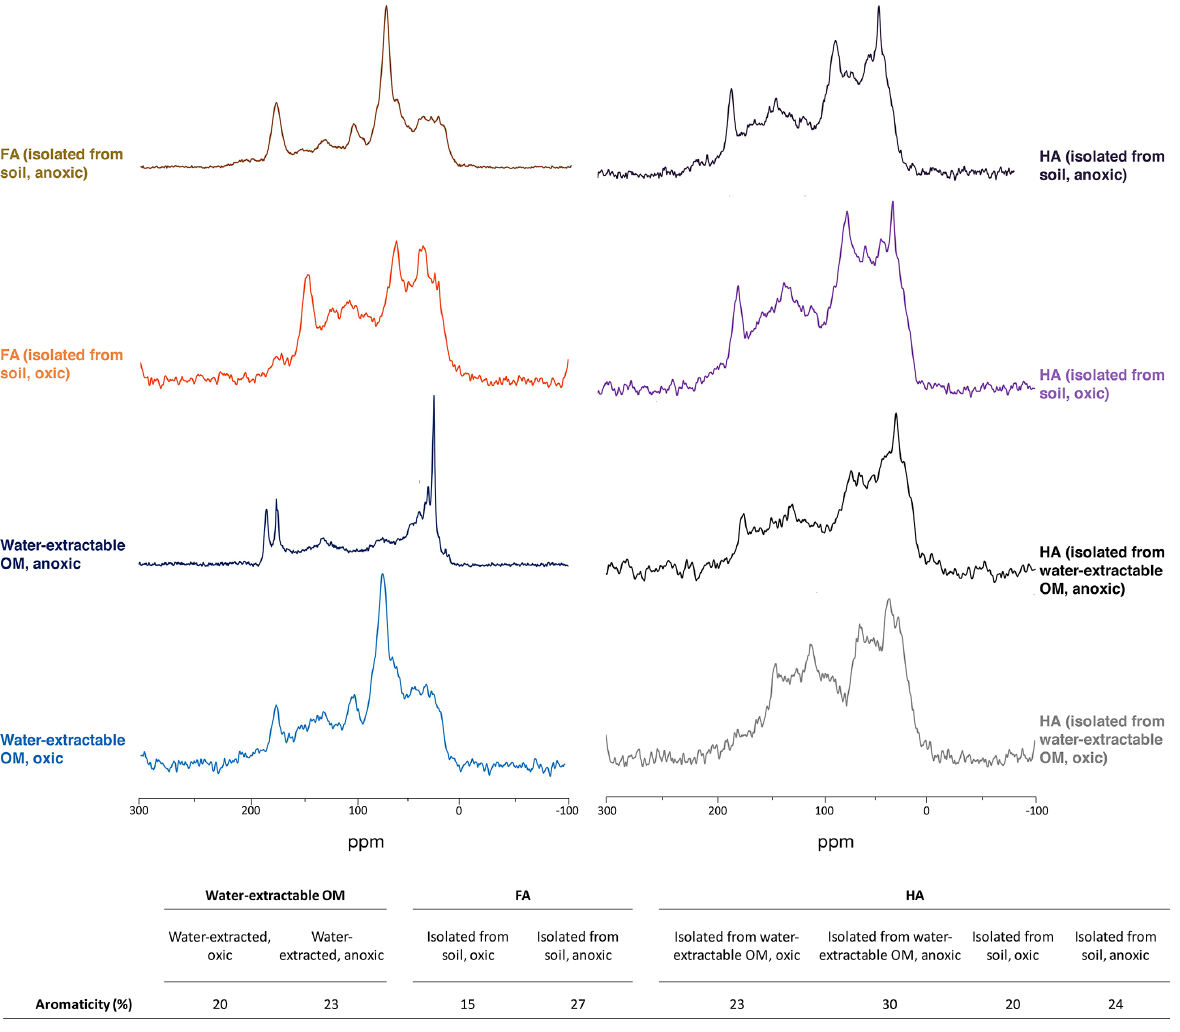
Figure 2. 13 C-NMR spectra of water-extractable OM, FA, and HA. All spectra were collected from freeze-dried extracts and the aromaticity of samples was calculated as the percentage of aromatic C peak area to the total peak area. The relative intensity distributions of specific chemical shifts are shown in the Supplement, Table S2. Spectra for FA isolated from water-extractable OM cannot be presented due to the lack of an adequate amount of sample for